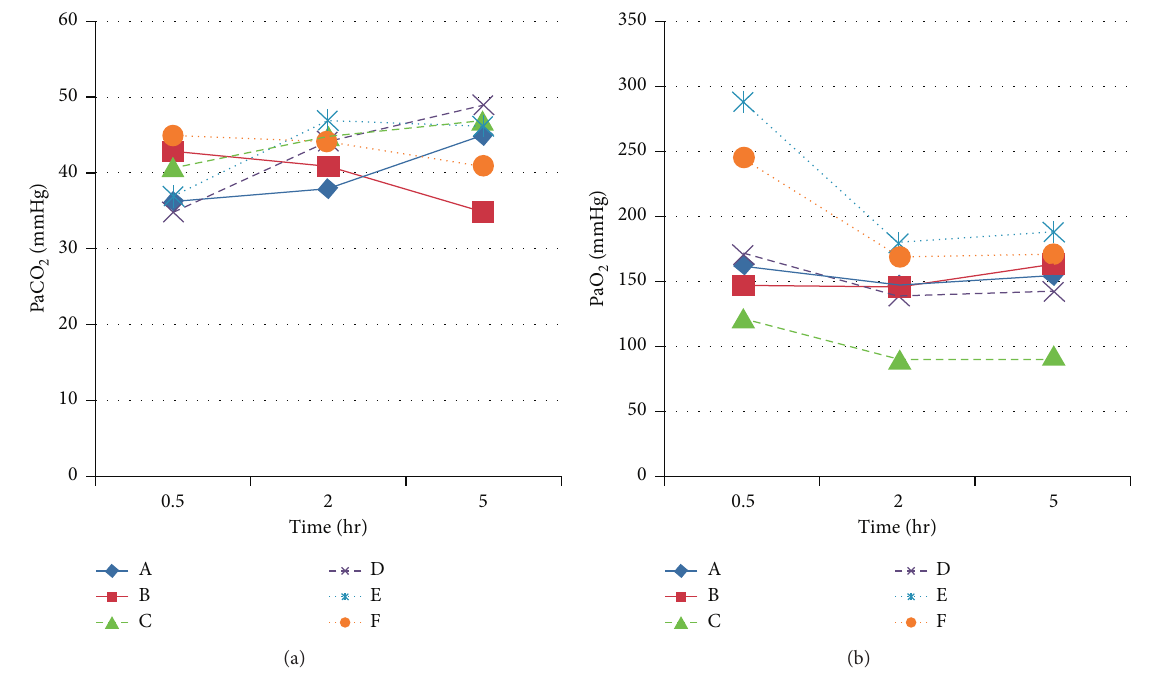
Figure 2: (a) PaCO � 30 minutes, 2hr, and 5 hr in all subjects. 2 and (b) PaO 2 registered at t Table 1: Primary and secondary outcome variables in the six animals throughout the